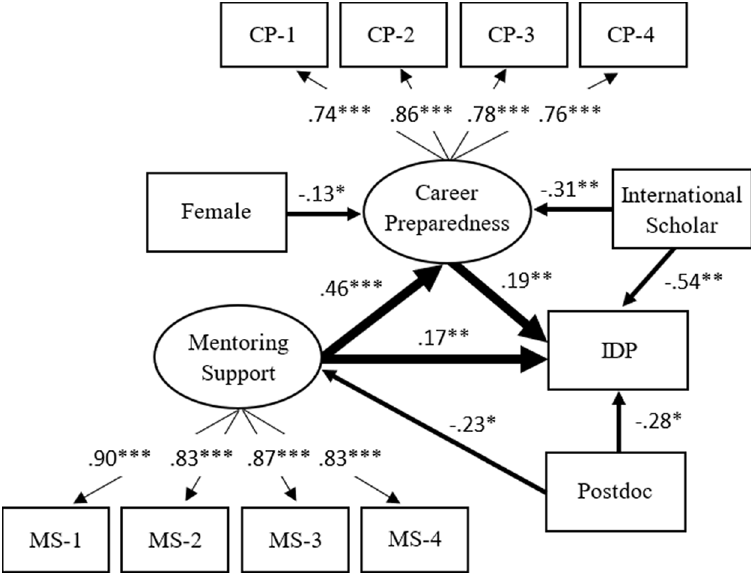
Figure 3. Model 2: Mentoring support and career preparedness as motivations for the use of individual development plan (IDP). Note. Value is standardized path coefficient. The values on the light arrows are standard- ized factor loadings. Given that the use of the IDP is binary, the coefficients on the path from variables to IDP are standardized probit coefficients. The Primary variables (IDP, mentoring support, and career preparedness) are controlled by gender, doctoral student/postdoctoral fellow, race/ethnicity, and citizenship status. Only the statisti- cally significant paths are shown in the figure. The reference group of the IDP is the trainee who did not use the IDP withtheirPI/advisorannually.Thereferencegroupoffemalesismale.ThereferencegroupofPostdoctoralfellowsis doctoral student. The reference group of international scholars is citizen or permanent resident. Oval represents a latent factor (measured by a set of indicators). Rectangle stands for an observed variable. MS-1 to MS-4 are the observed indicators of mentoring support, while CP-1 to CP-4 are the observed indicators of career preparedness. The full description for each of these indicators is shown in Table 1. * p < .05 ** p < .01 *** p <